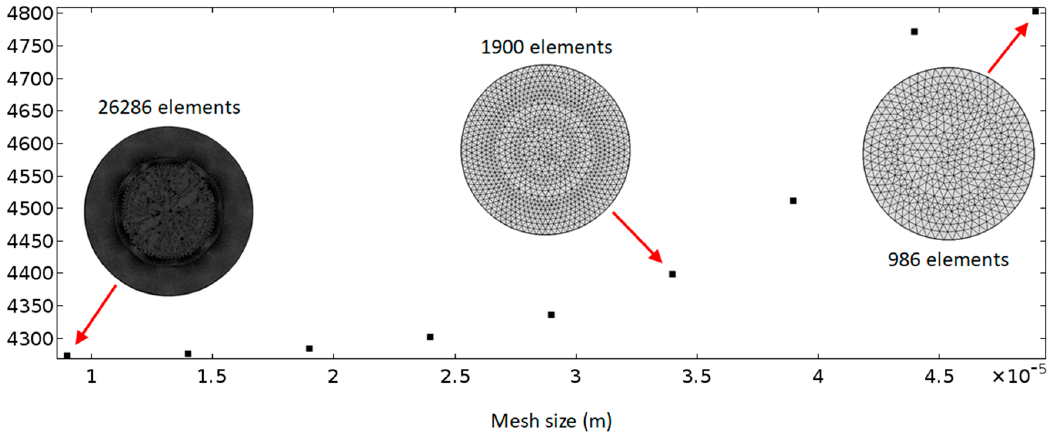
Figure 3. Mesh size-dependency studies. The vertical axis plots the average acoustic energy density (Pa) in the model